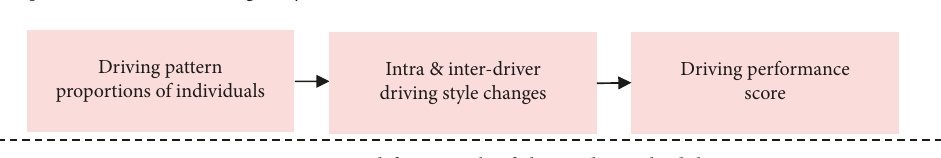
Figure 1: Proposed framework of the study